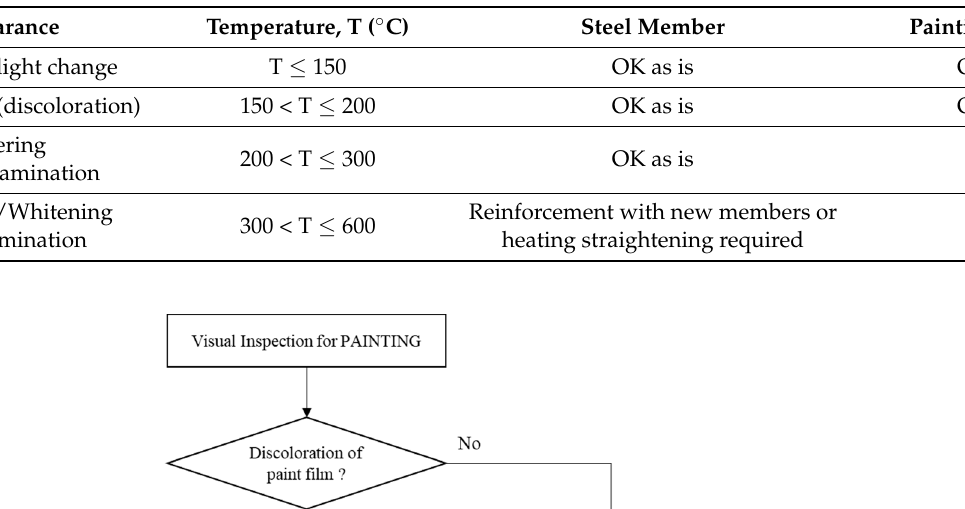
Table 10. Analysis of fire damage through visual inspection of coating’s surface conditions.